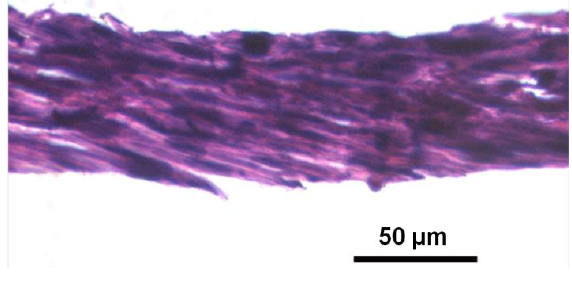
Figure 5. Thick, multilayered tissue constructs were formed with aligned nanofiber-cell sheets. The cross-section of a six-layered composite cell sheet construct stained with H&E demonstrates the adhesion among cell layers and cell